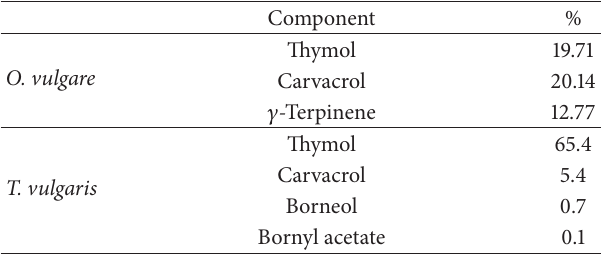
Table 1: Quantitative composition of O. vulgare and T. vulgaris essential oils.